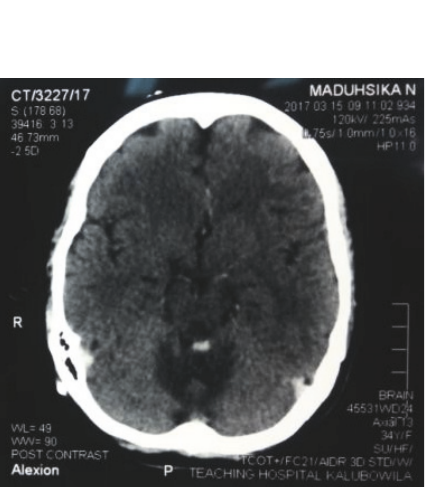
Figure 1: Noncontrast CT brain showed early hydrocephalus with a suspicion of a posterior fossa space occupying